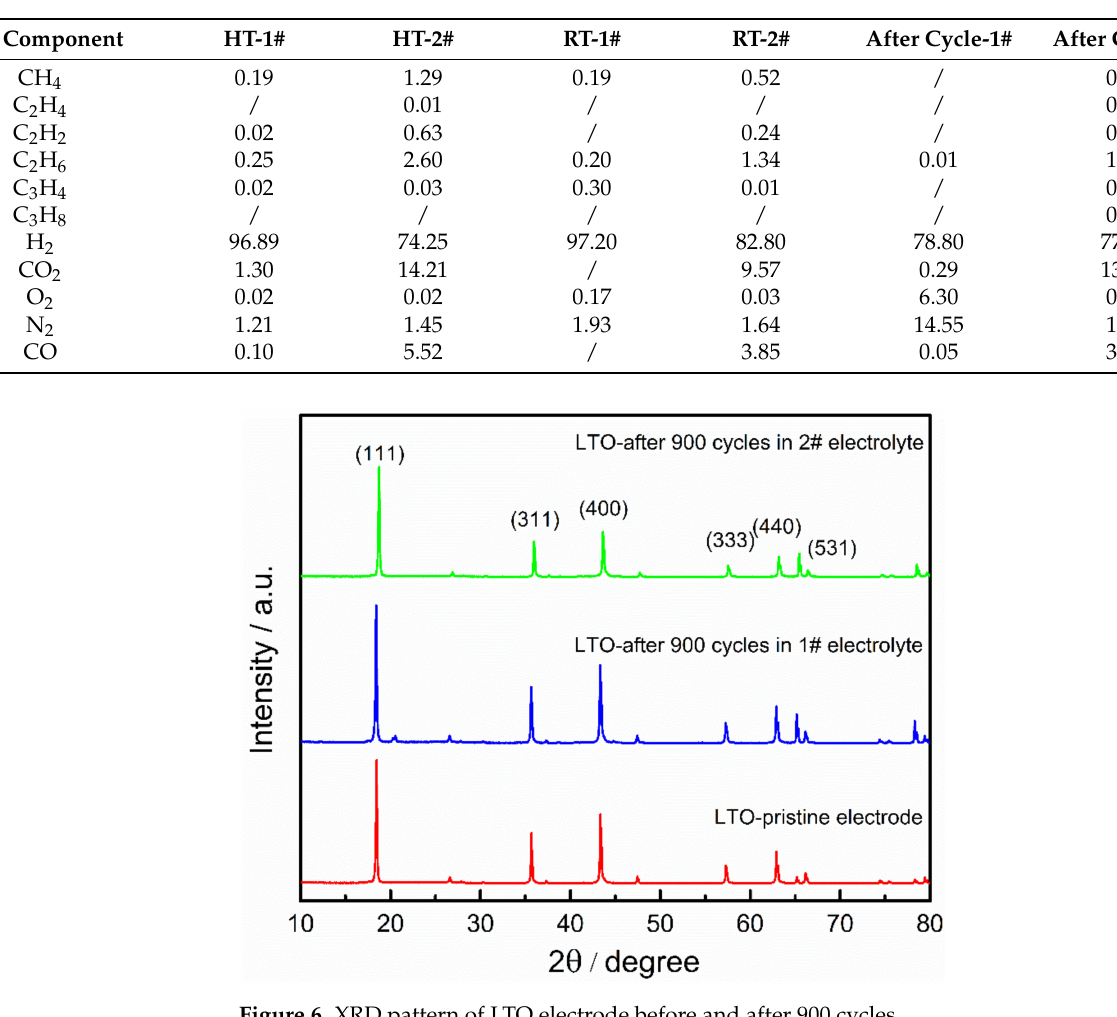
Figure 5. The gas composition of AC/LTO LIC at different states. Table 2. The volume fraction of various gas for AC/LTO LIC.